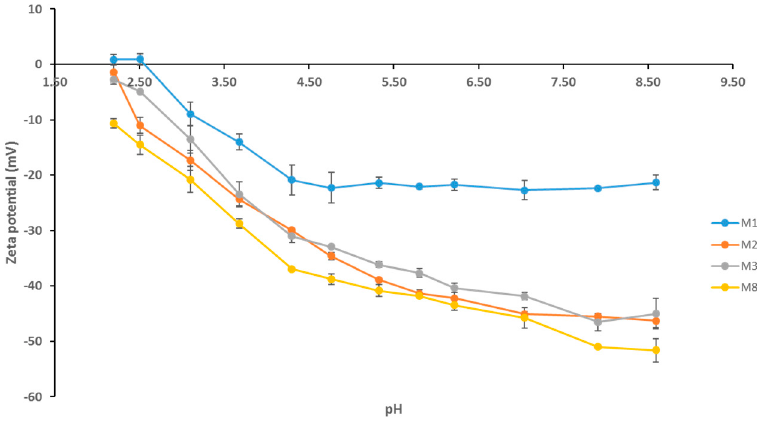
Figure 7. pH scan of selected PES membranes with resulting zeta potential measurements.